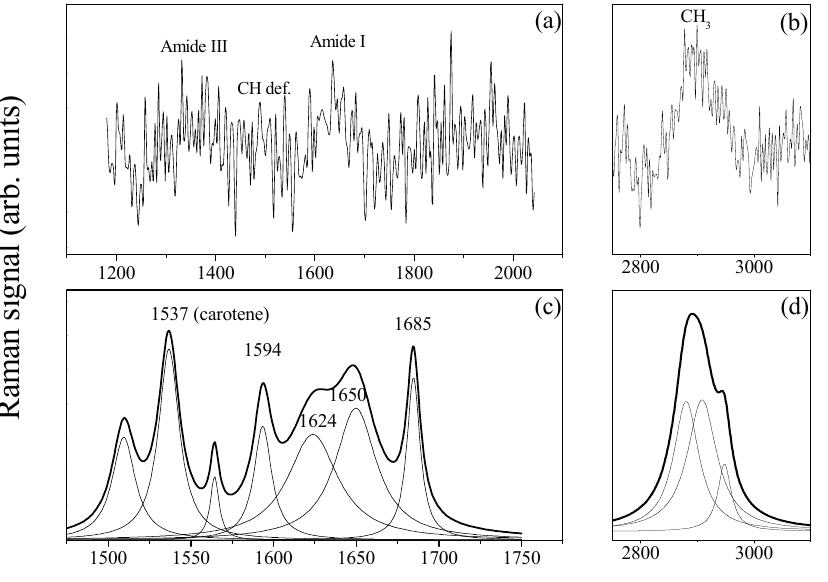
Figure 7. Raman spectrum of GCF from chronic Periodontitis affected patient, for the 1200–2000 cm − 1 ( a ); and 2500–3100 cm − 1 wavenumber range ( b ); Deconvolution in Gaussian/Lorentzian peaks of the Amide I spectrum region (1500–1750 cm − 1 ) ( c ); and CH 3 region (2800–3000 cm − 1 ) ( d